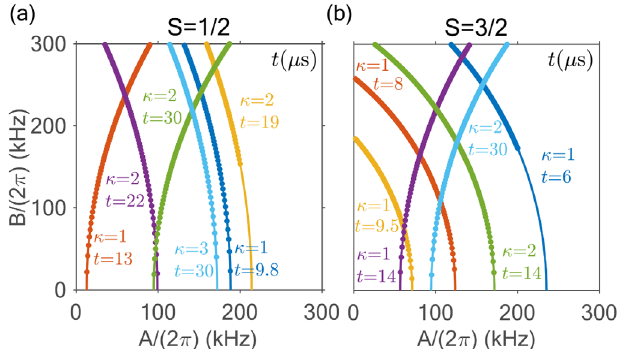
FIG. 2. Hyperfine parameters of nuclear spins that undergo a trivial evolution under the CPMG sequence. Each circle corre- sponds to a constant time of one CPMG unit and different value of κ [see the main text]. In (a), we select the electron ’ s spin projections s 0 ¼ − s 1 ¼ 1 = 2 and in (b) s 0 ¼ 3 = 2 and s 1 ¼ − 1 = 2 . 2 π · 314 kHz. The Larmor frequency is considered to be ω L ¼ For illustration purposes, we show mainly times t ∈ Z þ , but t could also take any positive noninteger